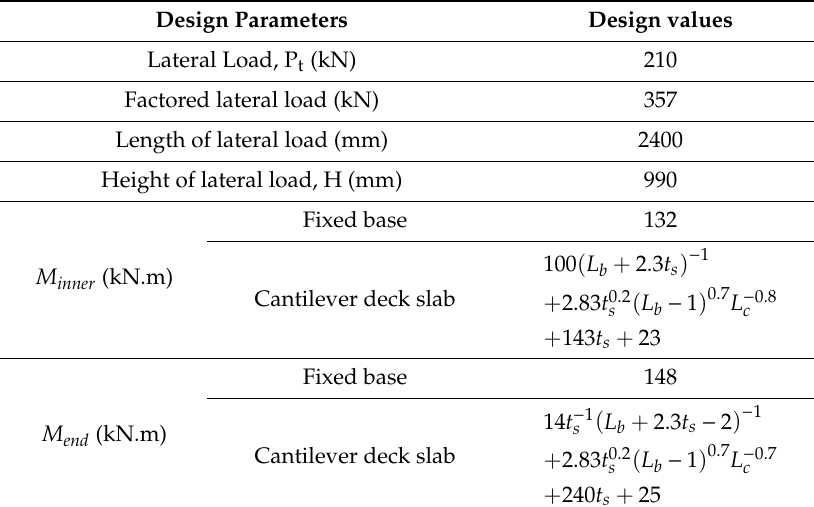
Figure 32. Design factors of safety for TL-5 barrier in Figure 1b at end location. 5. Conclusions Based on the experimental findings in this research, the following conclusions can be made: •